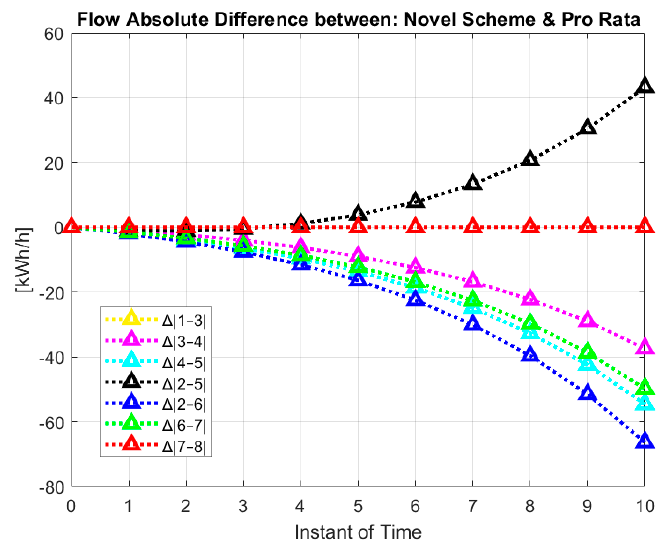
Figure 6. Absolute differences between the pipeline flow outcomes obtained with novel scheme and only Pro Rata method related to the set of all fl ows in the network.